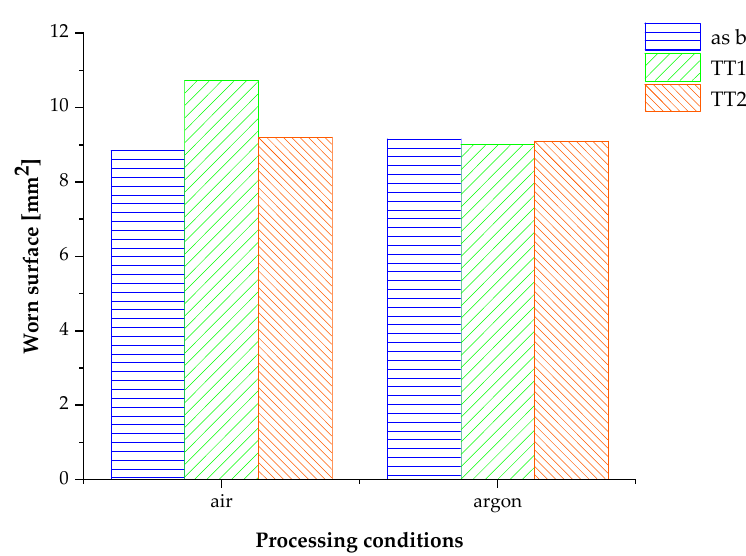
Figure 16. Worn track area values obtained after the tribological tests.